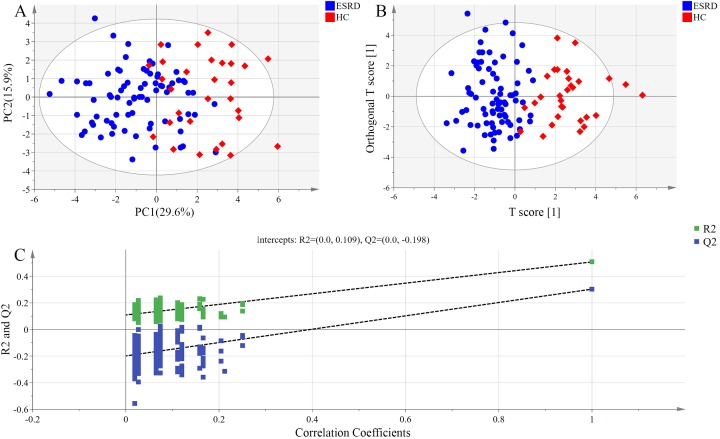
Metabolomic analysis of serum samples.(A) PCA score plots. Ellipse:Hotelling’s T2 (95%). (B) OPLS-DA score plots showing a clear discrimination between ESRD (blue sphere) and HC subjects (red octahedron). Ellipse:Hotelling’s T2 (95%). (C) Permutation test demonstrating the robustness of OPLS-DA model. R2 = 0.109 and Q2 = −0.198.